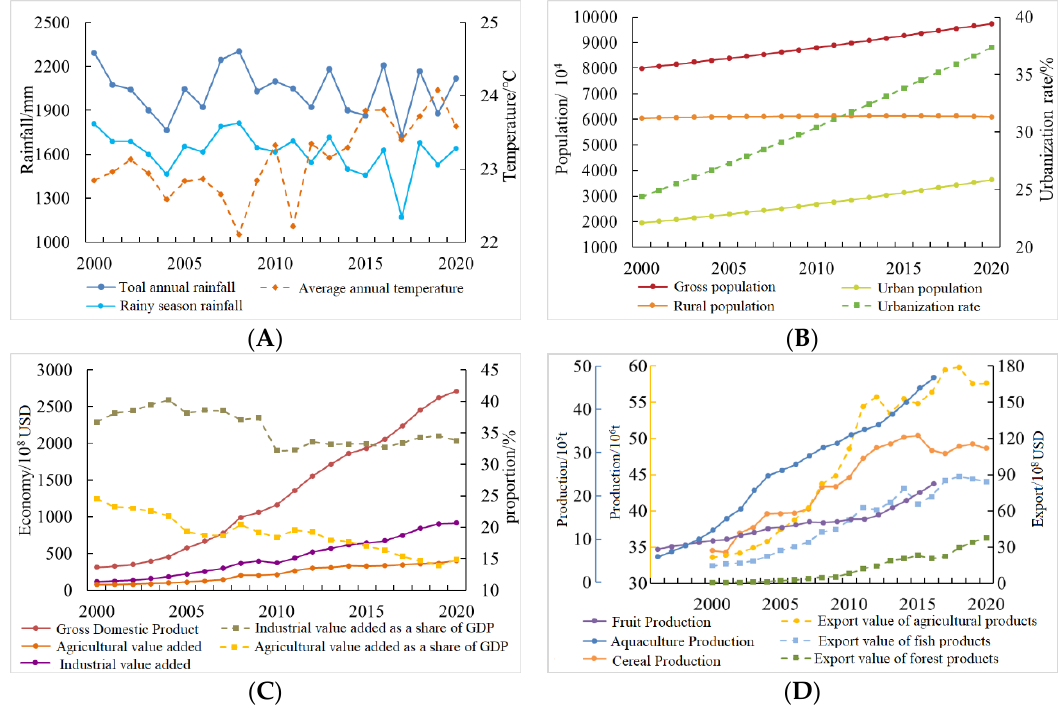
Figure 6. Development status in Vietnam from 2000 to 2020. ( A ) Climatic factors, ( B ) Population factors, ( C ) Economic factors, ( D ) Production and export factors.